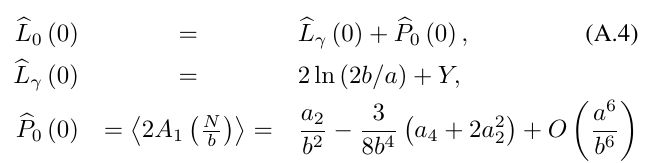
Figure 3: Two non-adjacent coplanar straight